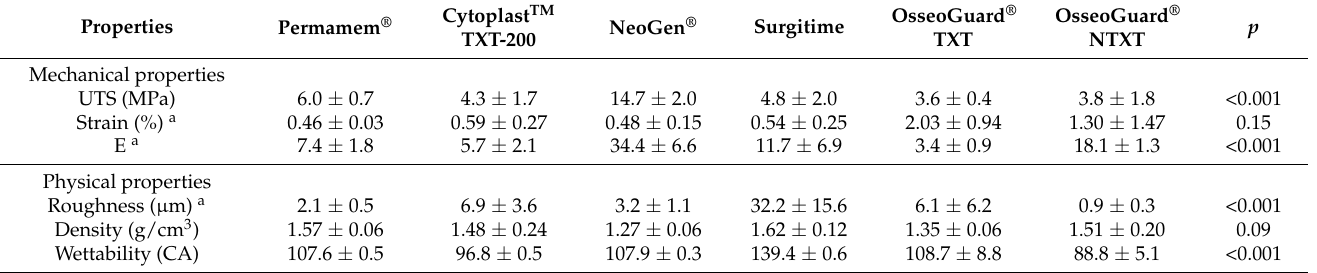
Table 3. Mechanical and physical properties of the PTFE membranes examined (mean ± SD).